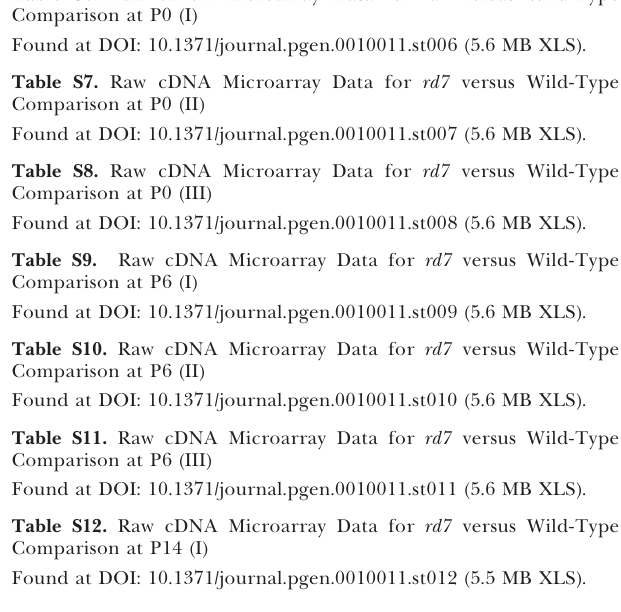
Table S13. Raw cDNA Microarray Data for rd7 versus Wild-Type Comparison at P14 (II) Found at DOI: 10.1371/journal.pgen.0010011.st013 (5.6 MB XLS). Table S14. Raw cDNA Microarray Data for rd7 versus Wild-Type Comparison at P14 (III) Found at DOI: 10.1371/journal.pgen.0010011.st014 (5.6 MB XLS). Table S15. Raw Affymetrix Microarray Data for rd7 versus Wild-Type Comparison at P21 (I) Found at DOI: 10.1371/journal.pgen.0010011.st015 (18 MB XLS). Table S16. Raw Affymetrix Microarray Data for rd7 versus Wild-Type Comparison at P21 (II) Found at DOI: 10.1371/journal.pgen.0010011.st016 (18 MB XLS). Table S17. Raw Affymetrix Microarray Data for rd7 versus Wild-Type Comparison at P21 (III) Found at DOI: 10.1371/journal.pgen.0010011.st017 (18 MB